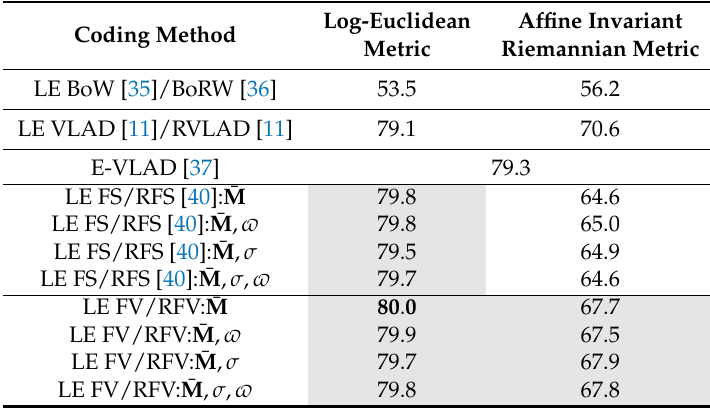
Table 8. Classification results on the HOCoffee database (6